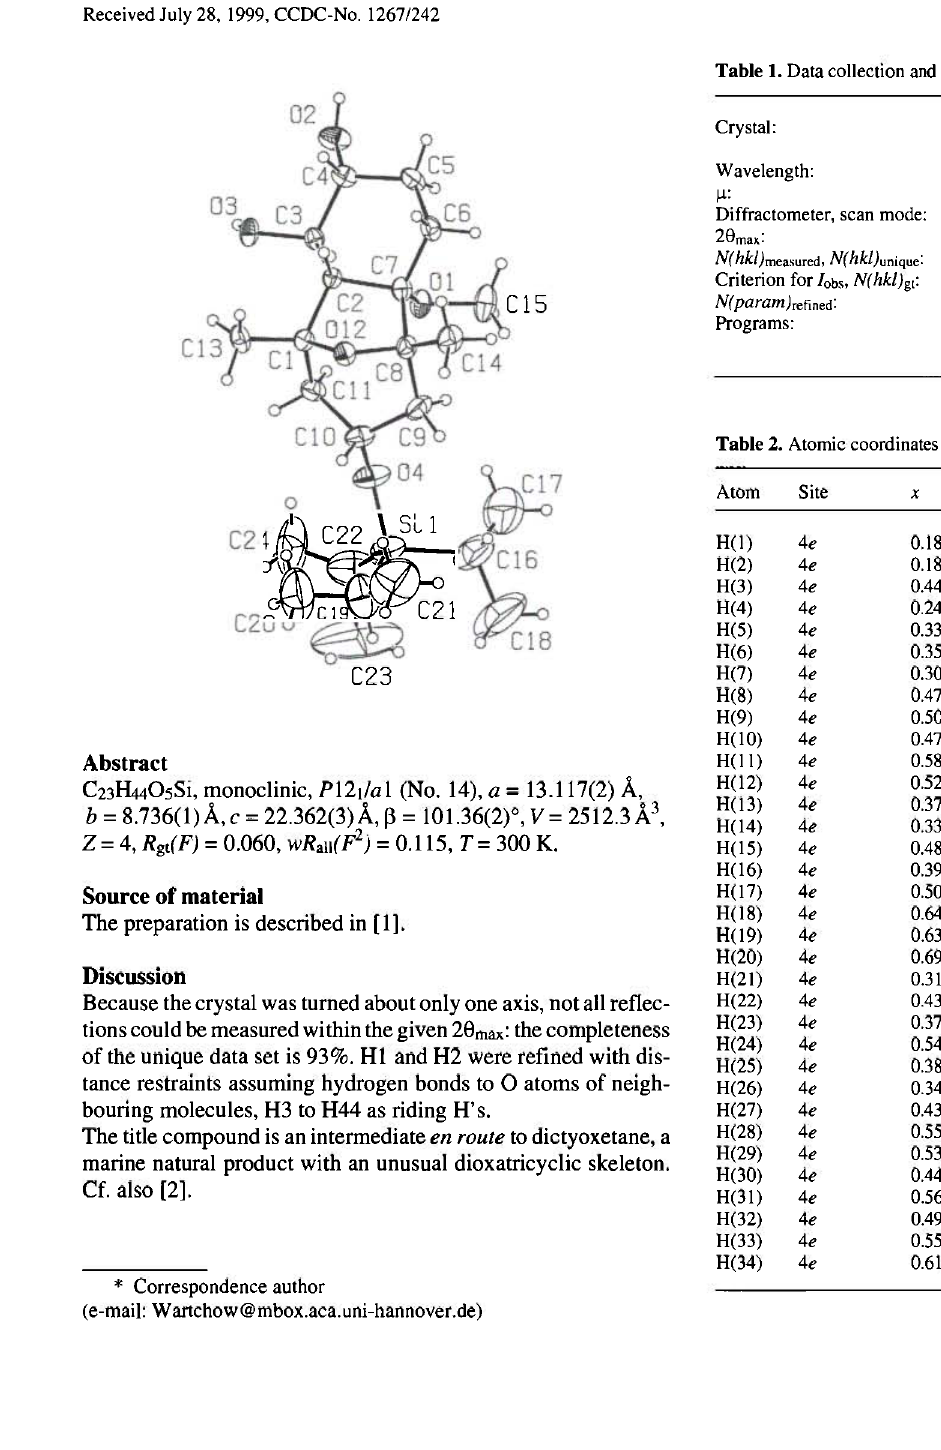
Table 1. Data collection and handling.